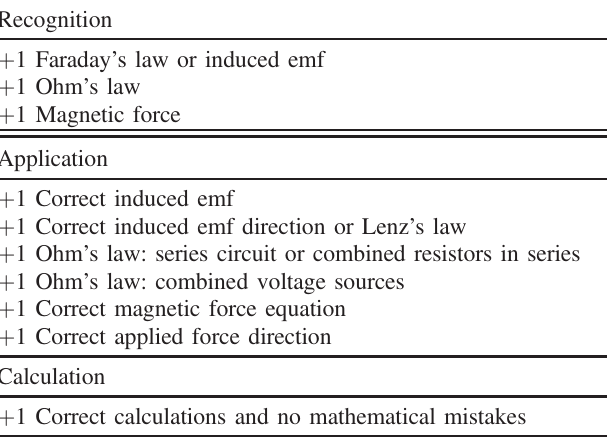
TABLE IV. Scoring rubric for the target synthesis problem. 1 point was awarded for each item, for a total of 10 points. Recognition